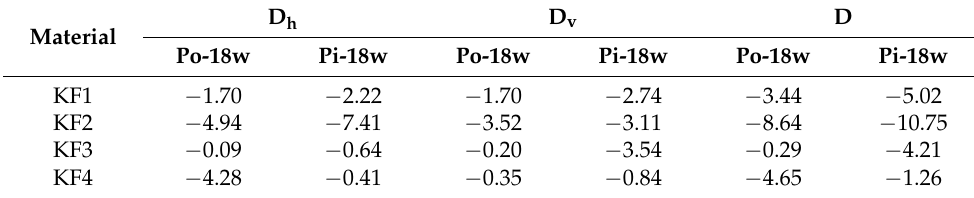
Table 4. The changes of densities, expressed in %, in comparison to non-aged materials.